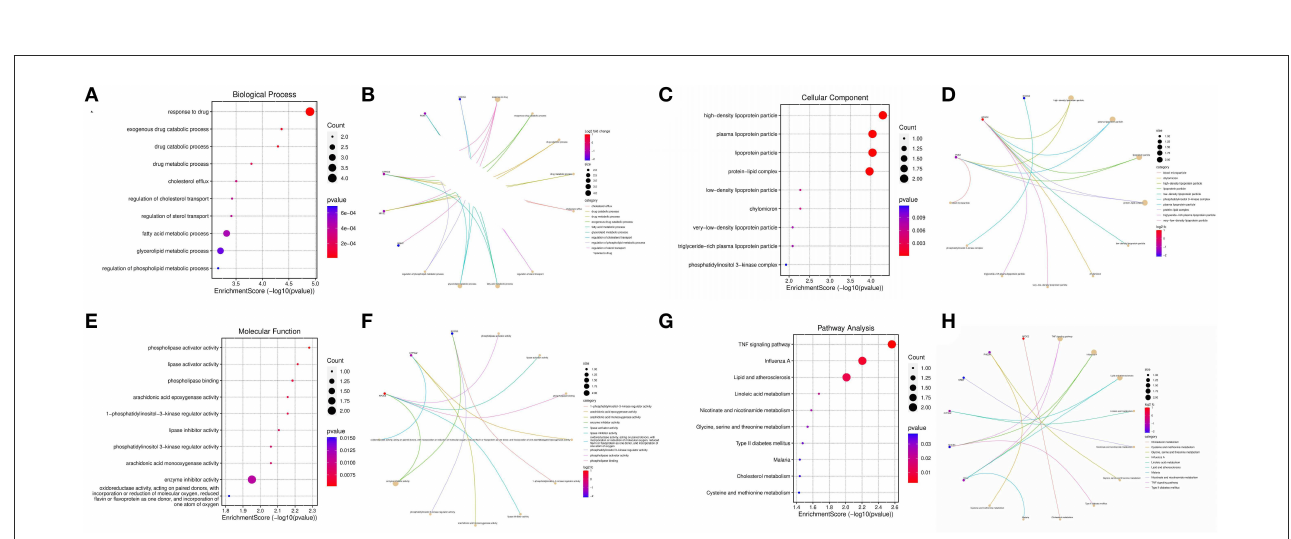
FIGURE7 Enrichment analysis; (A) BP enrichment bubble plot; (B) BP enrichment plot; (C) CC enrichment bubble plot; (D) CC enrichment plot; (E) MF enrichment bubble plot; (F) MF enrichment plot; (G) KEGG enrichment bubble plot; (H) KEGG enrichment